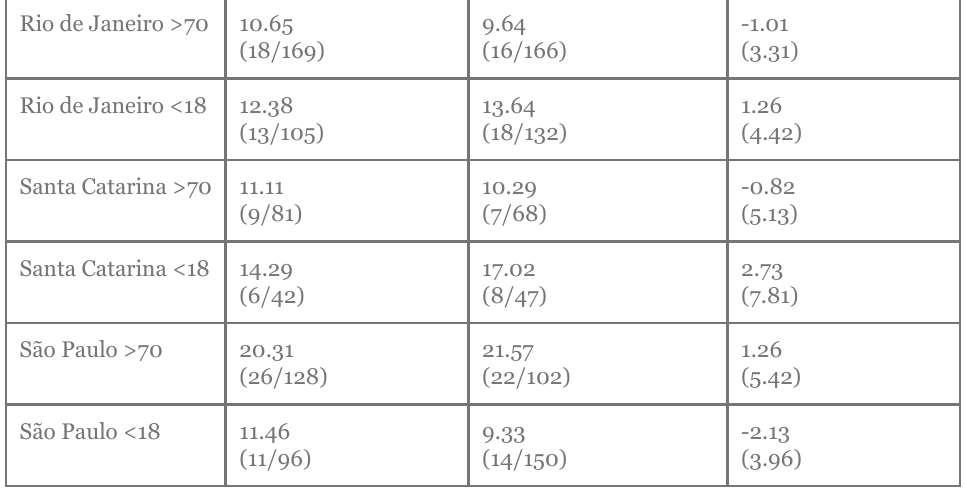
Table 7. Robocall